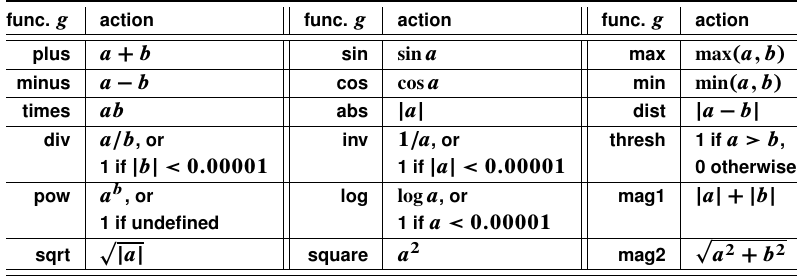
Table 1. Pool of GP functions, G long , with action on inputs a and b (where b is sometimes disregarded). func.